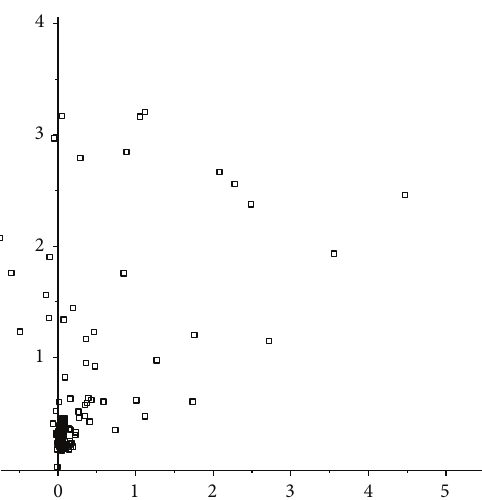
Figure 2: Consider the following system ( 𝑎 Δ 0.4 ℎ,∗ 𝑥)(𝑛ℎ) = 𝑦(𝑏 + 𝑛ℎ) , ( Δ 0.5 𝑦)(𝑛ℎ) = 𝐵𝑥(𝑎 + 𝑛ℎ) , where 𝐵 is given in Example 22, with 𝑏 ℎ,∗ initial conditions: 𝑥 0 = (0,1) , 𝑥 𝑎 = (0,0.1) , ℎ 0.9 𝐴 − ( 0.9 2 )𝐼 2 ∉ R 2×2 +